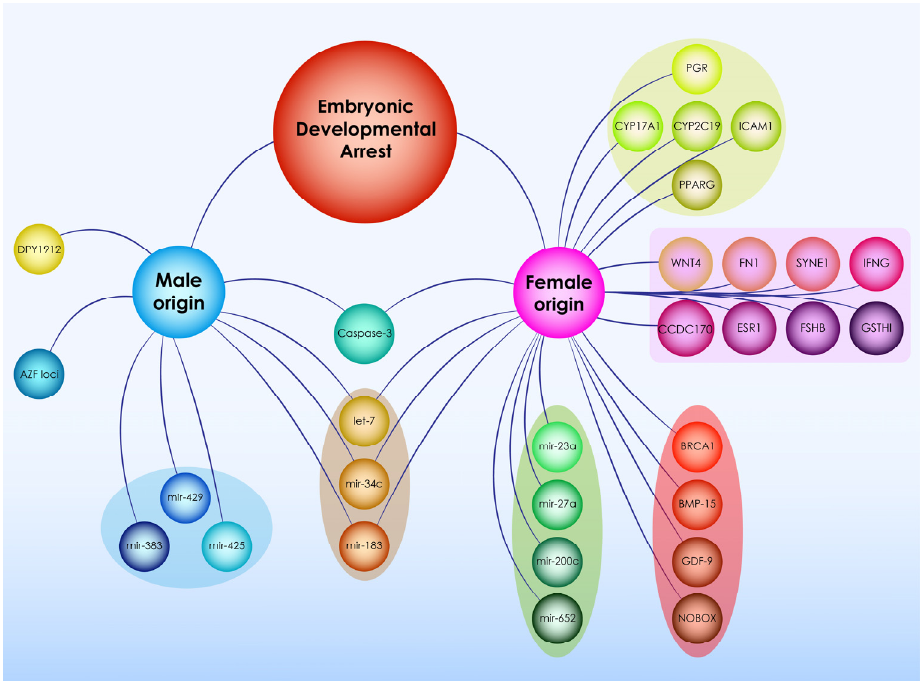
Figure 3. Mapping future research areas in arrested development of the human preimplantation embryo.